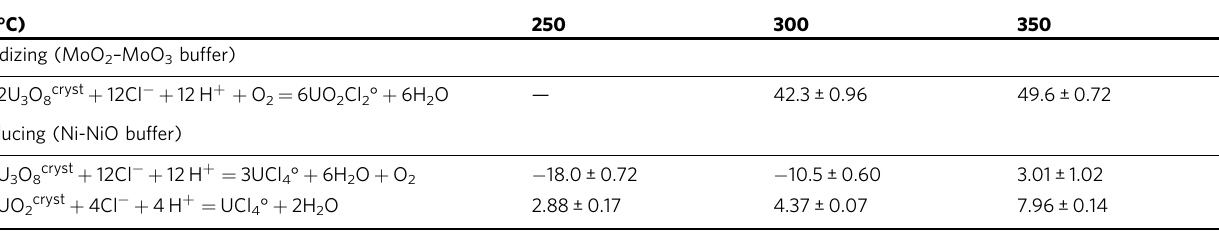
Table 1 Logarithms of equilibrium constants and their associated 1 σ uncertainty for uranium oxide dissolution reactions